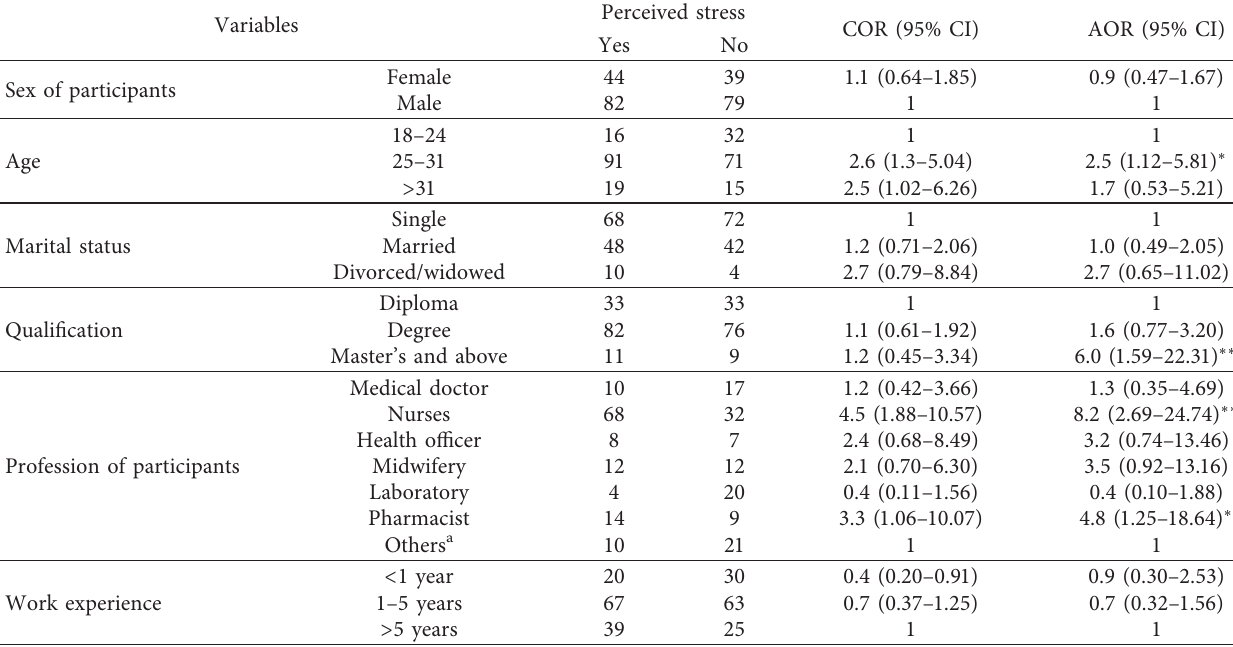
Table 3: Bivariate and multivariate analysis of factors associated with perceived stress on COVID-19 among healthcare providers in Dilla town, Southern Ethiopia,